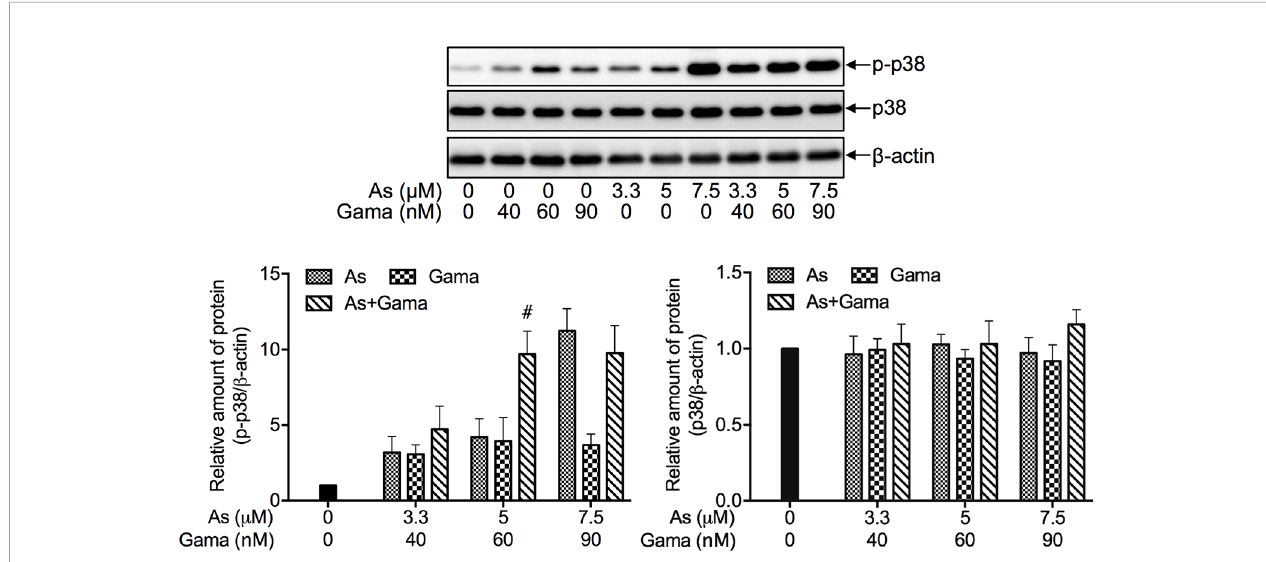
FIGURE 6 | Effect of relatively high concentrations of As III and gamabufotalin on the expression level of phospho-p38 and its total form in U-87 cells. Following treatment for 48 h with various concentrations of As III (3.3, 5, 7.5 µM) and gamabufotalin (40, 60, 90 nM), alone or in combination, the expression pro fi les of phospho-p38 (p-p38) and p38 were analyzed using western blotting. A representation image of the expression pro fi le of each protein is shown from three independent experiments. The expression levels were expressed as the ratios between each targeted protein and b -actin protein expression levels, and were compared with those of control group. A p value less than 0.05 was considered as statistically signi fi cant ( # p < 0.01 vs. each alone). As, As III ; Gama,